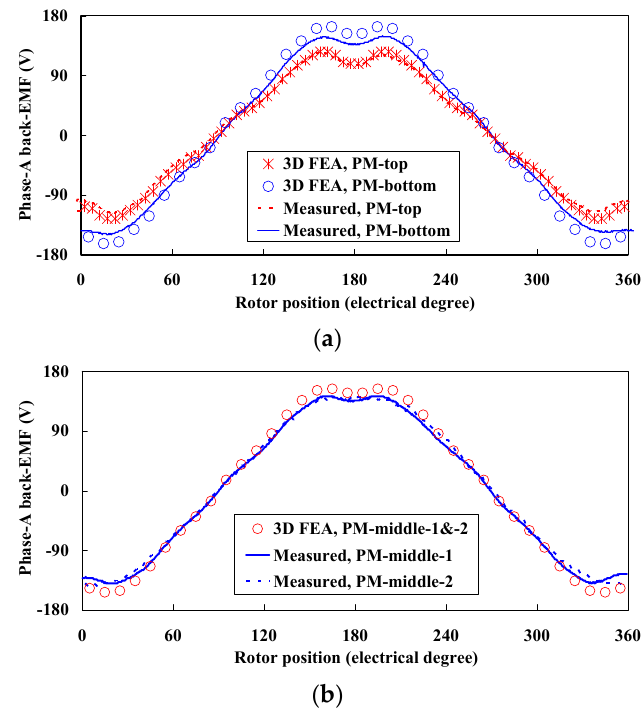
Figure 21. 3D FEA predicted and measured no ‐ load phase ‐ A back ‐ EMF waveforms due to PMs only, at 1500 r/min. ( a ) PM ‐ top and ‐ bottom; ( b ) PM ‐ middle ‐ 1 and ‐ 2.